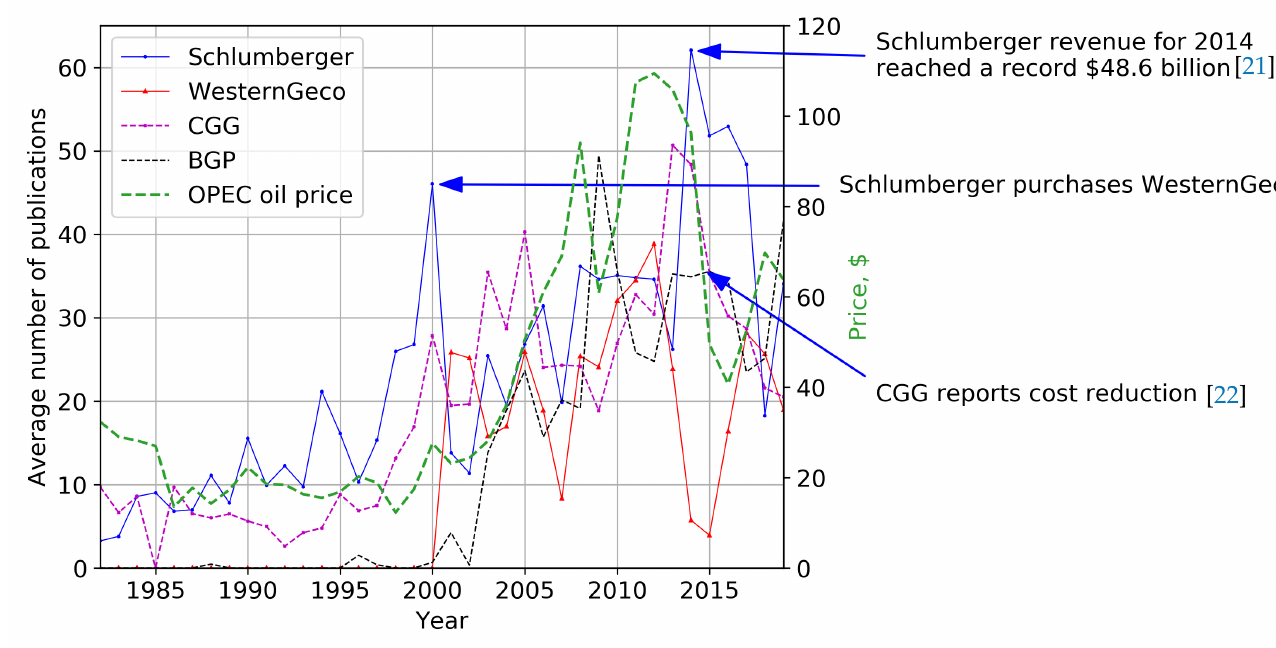
Figure 8. The average number of publications by oil-service companies and OPEC crude oil